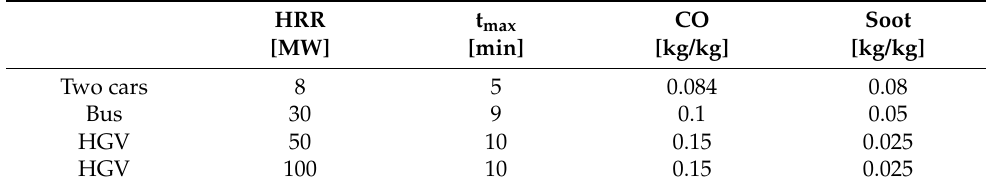
Table 1. Heat release rate (HRR) and yields of combustion